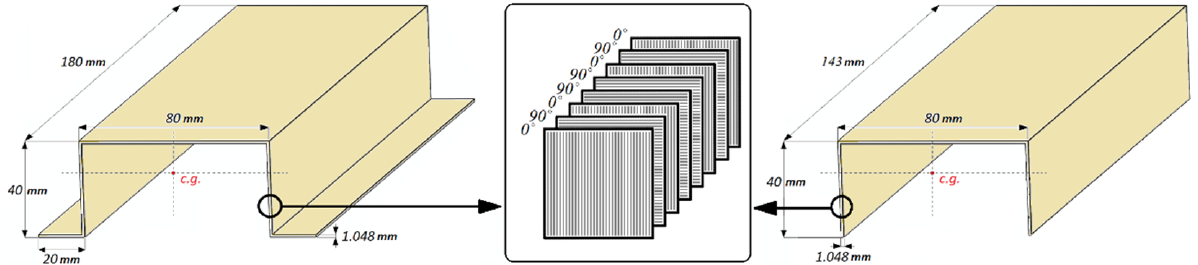
Figure 1. Geometrical parameters of specimens.